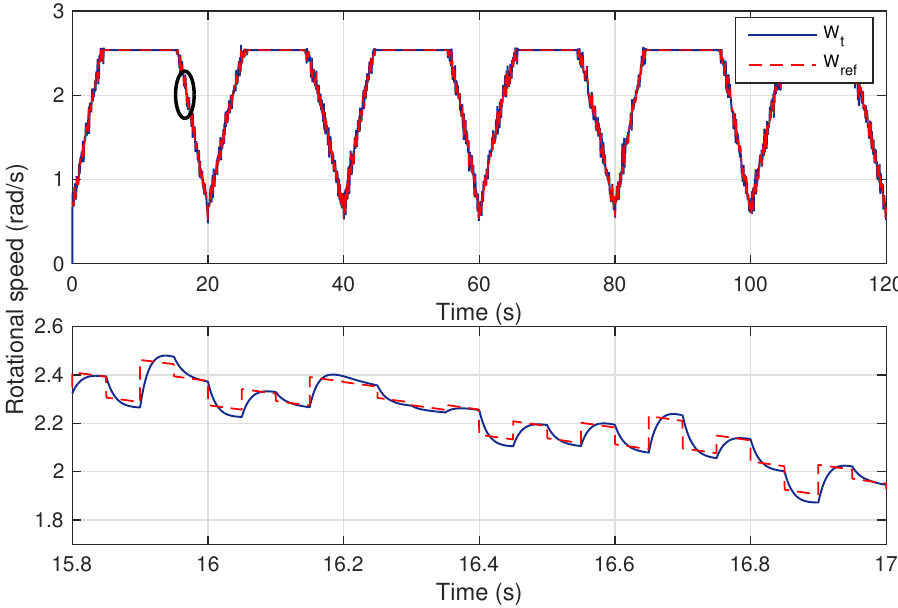
Figure 18. Case 1: Rotational speed and its reference curves.